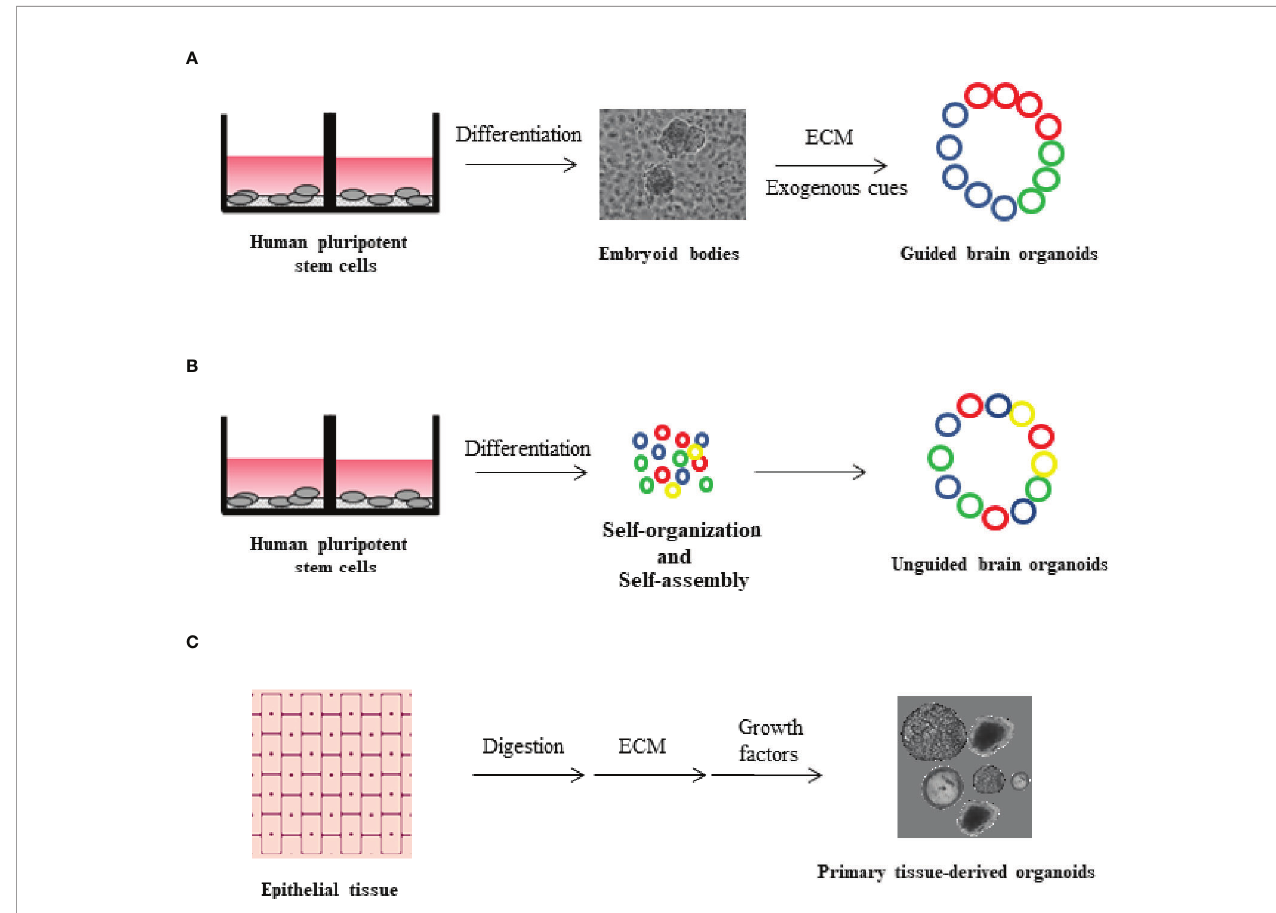
FIGURE 1 | Organoid formation technologies from human pluripotent stem cells (hPSCs) and primary tissue. (A) Guided brain organoids generated from hPSCs through embryoid body (EB) formation. The process requires extrinsic factors, such as extracellular matrix (ECM) and exogenous differentiation signals. The presence of different cell types in the organoids is indicated by different colors (blue, red and green) (B) Unguided brain organoids generated from hPSCs upon stem cell self- organization and self-assembly, in the absence of extrinsic factors. With this method, non-ectodermal cell types may be incorporated in brain organoids (yellow color) (C) Primary tissue-derived organoids are generated by human epithelial tissue of any age. Described protocols include tissue digestion and subsequent use of de fi ned cell culture media supplemented with tissue-speci fi c growth factors. Organoids are embedded in